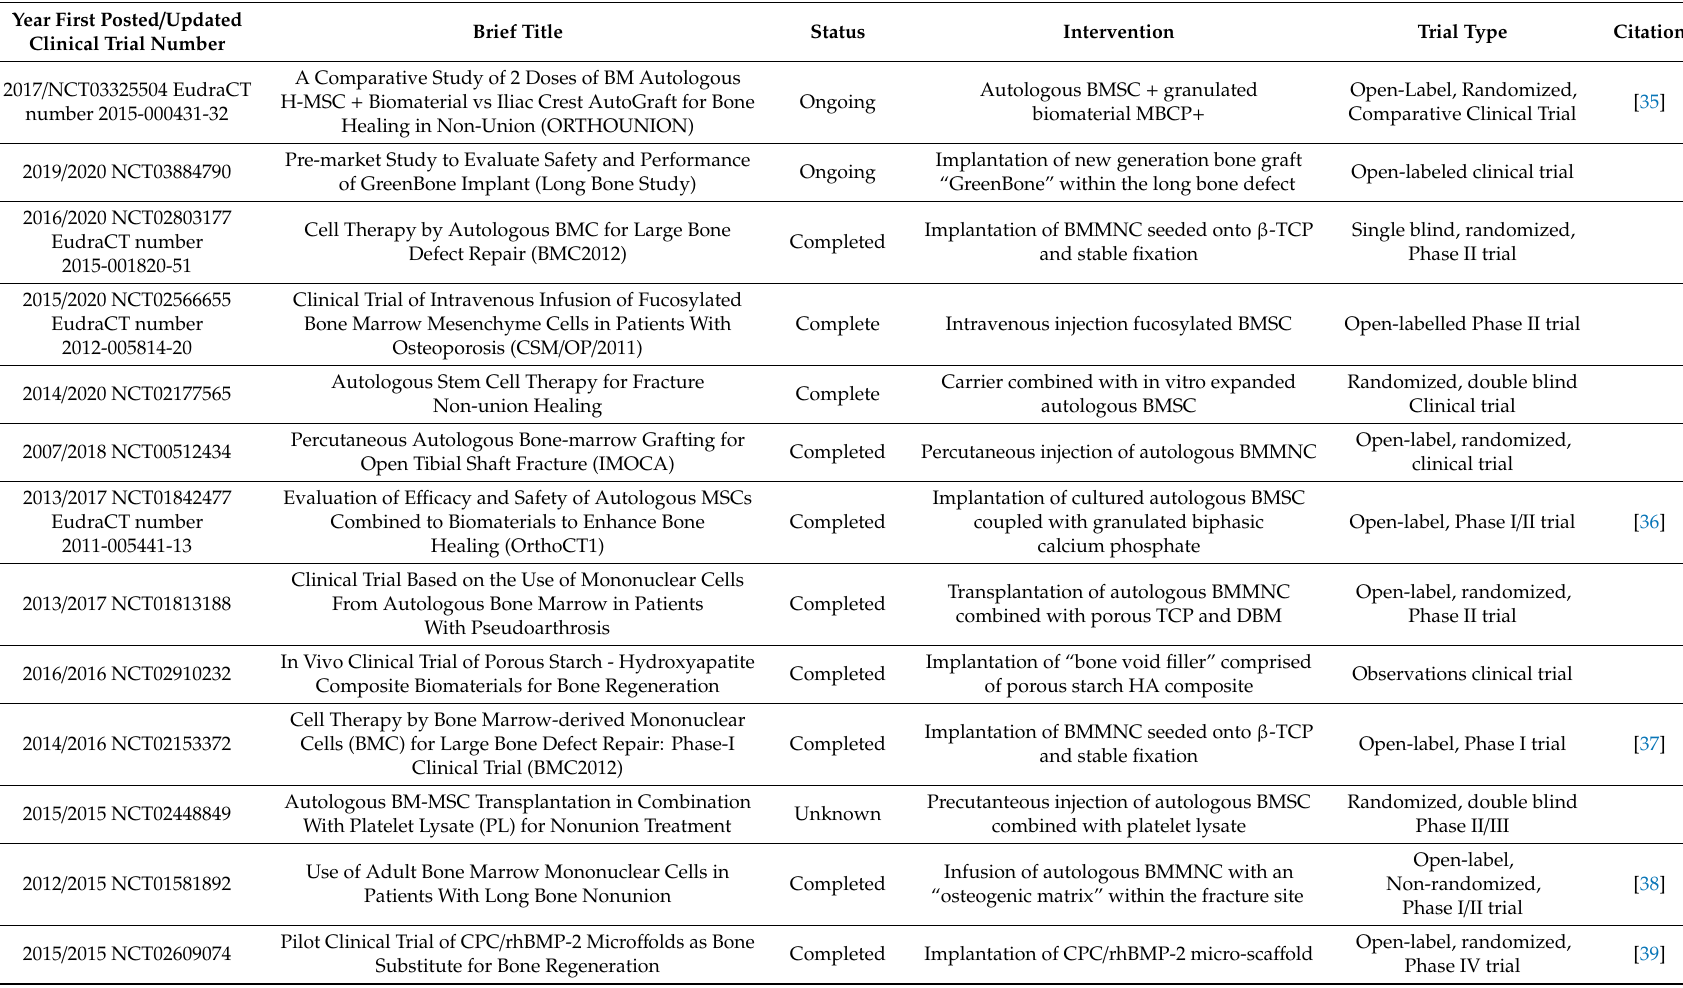
Table 1. Clinical Trials in Fracture Repair. Search criteria in ClinicalTrails.gov: BMSC and bone fracture, sca ff old and bone fracture, stem cells and sca ff old and bone fracture. Terminated, suspended and withdrawn trials and cartilage related trials have been removed from the